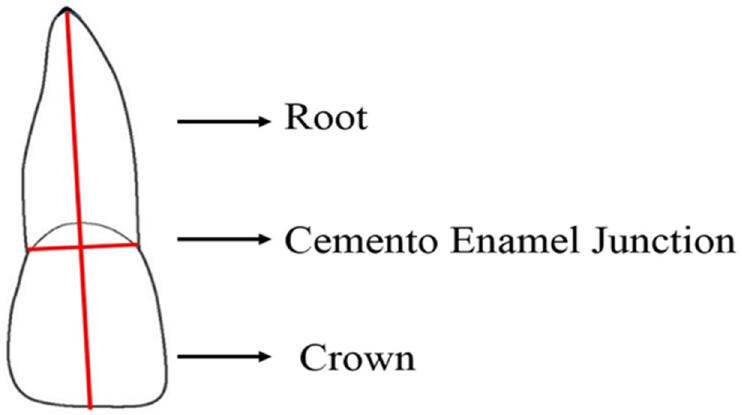
Figure 2. Diagrammatical presentation for the measurements of the tooth root and crown length.